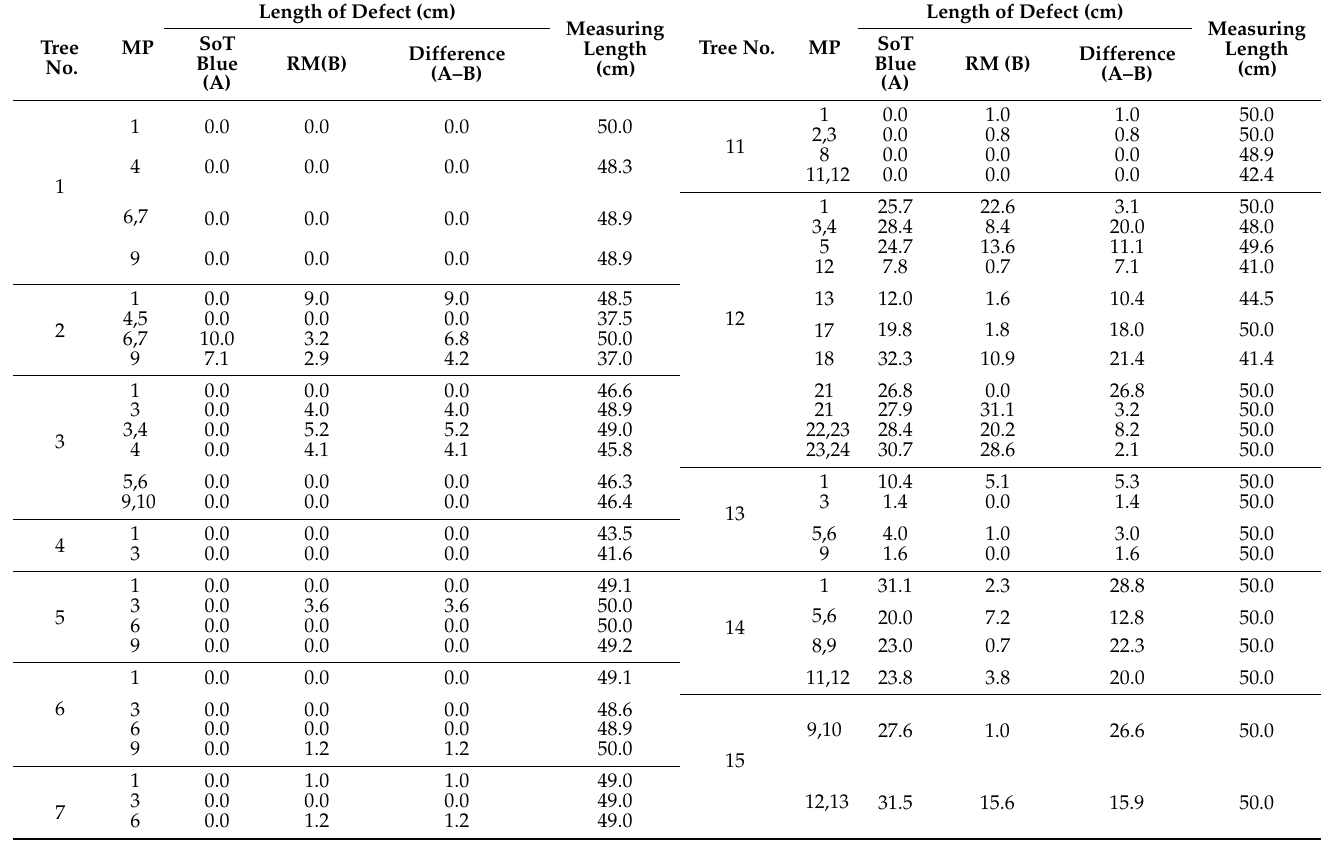
Table 4. Results of t -test on the lengths of defects measured using SoT and RM (n =